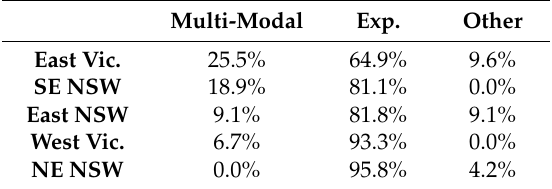
Table 3. Percentage of source fires of each distribution type by